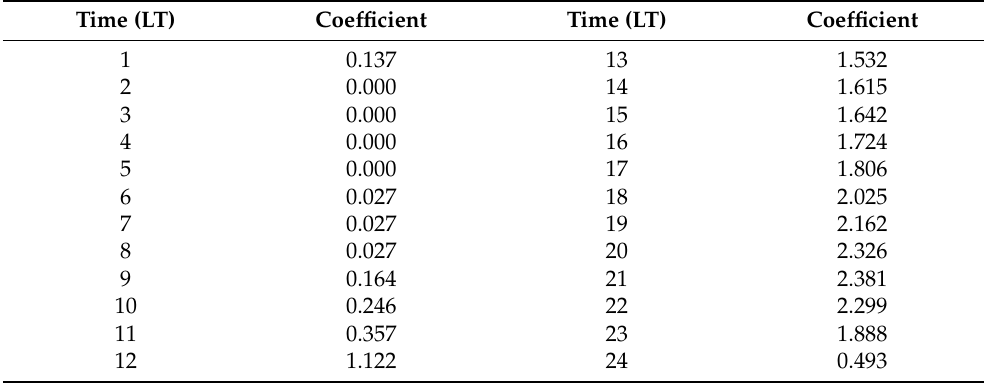
Table 6. Daily coefficients representing the operation of restaurants in Attica.